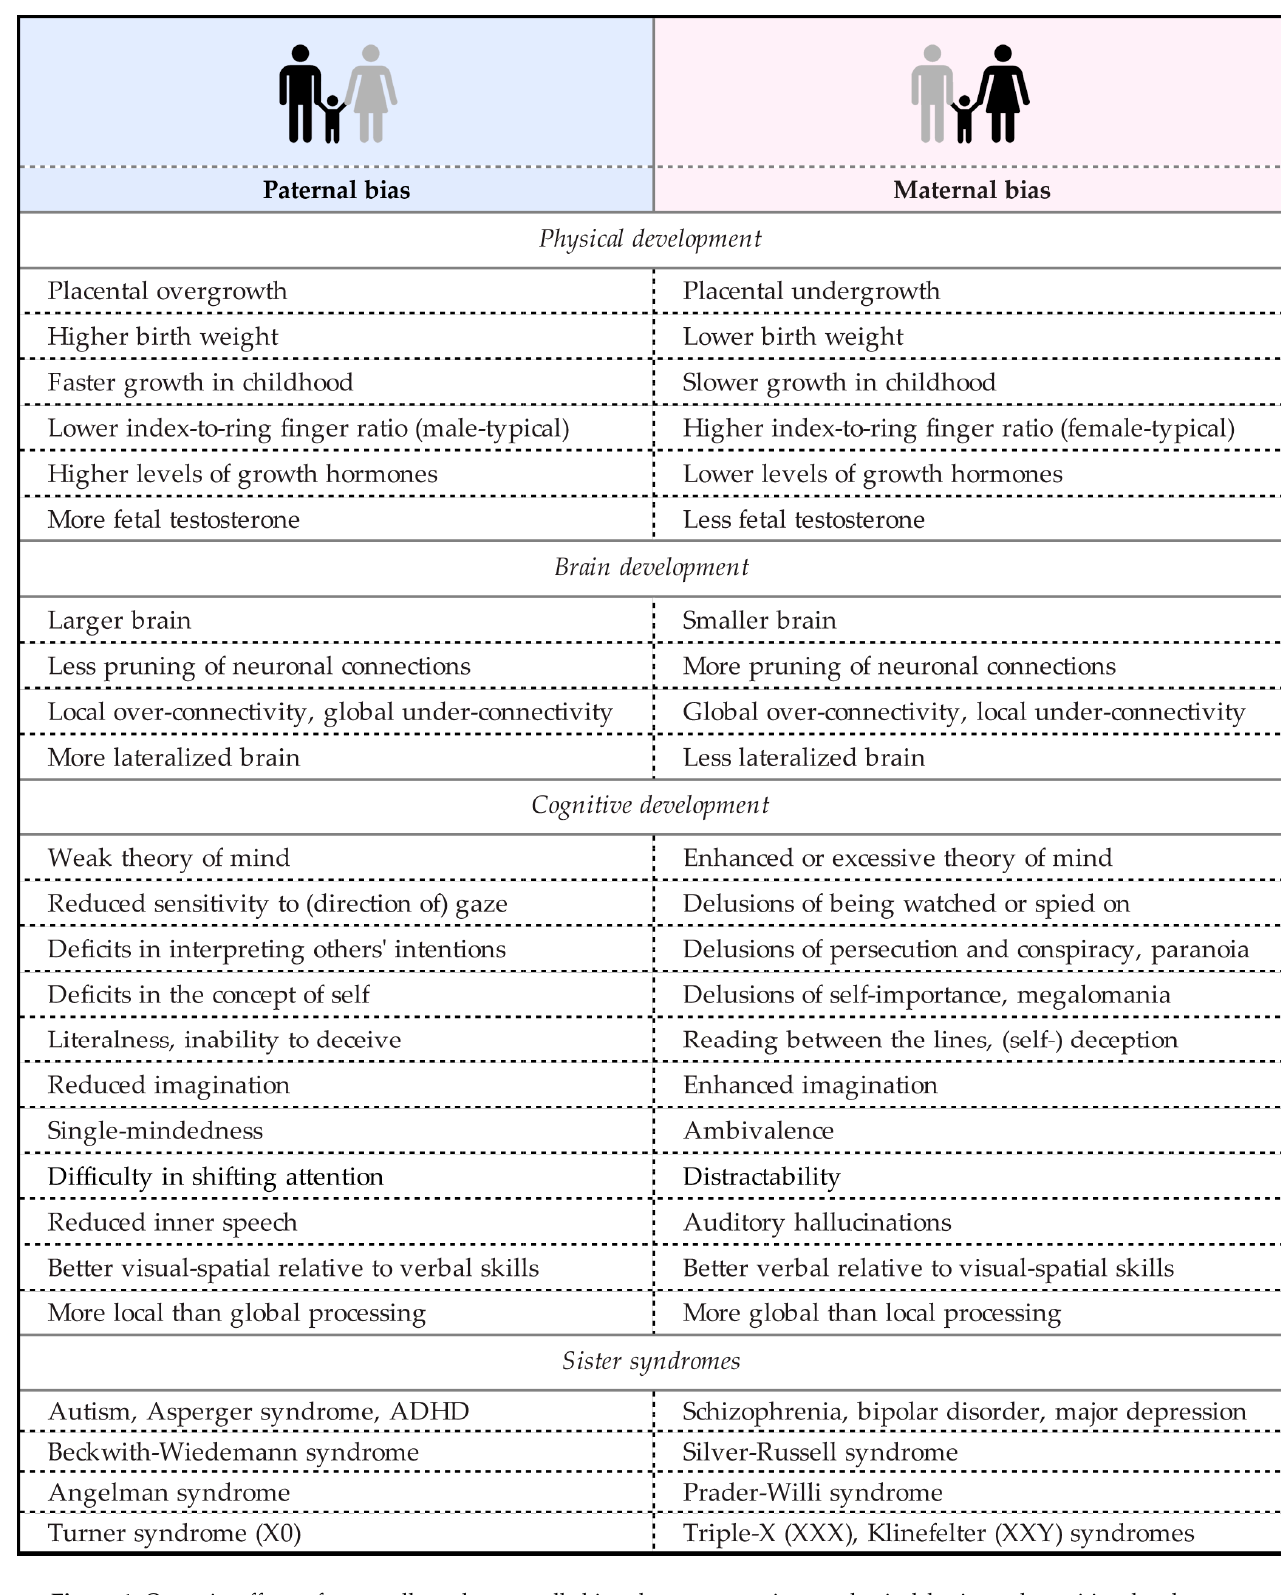
Figure 1. Opposite effects of paternally and maternally biased gene expression on physical, brain, and cognitive development and corresponding disorders of neurodevelopment (sister syndromes). (For references see [27]. Icon: Alina Oleynik from the Noun Project, adapted.)